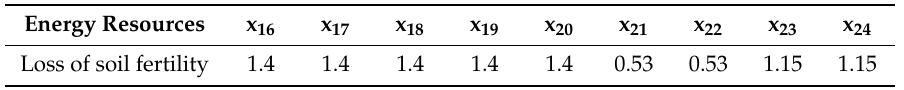
Table 9. Loss of soil fertility caused by the production of energy resources (in t / ha) according to scenario I. Energy Resources Source: Own study based on the